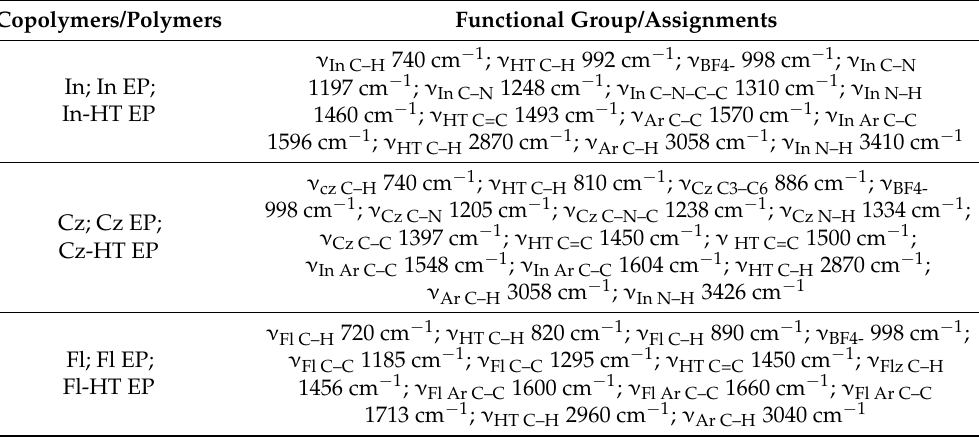
Table A1. Group frequency assignments for major infrared bands observed in obtained materials.